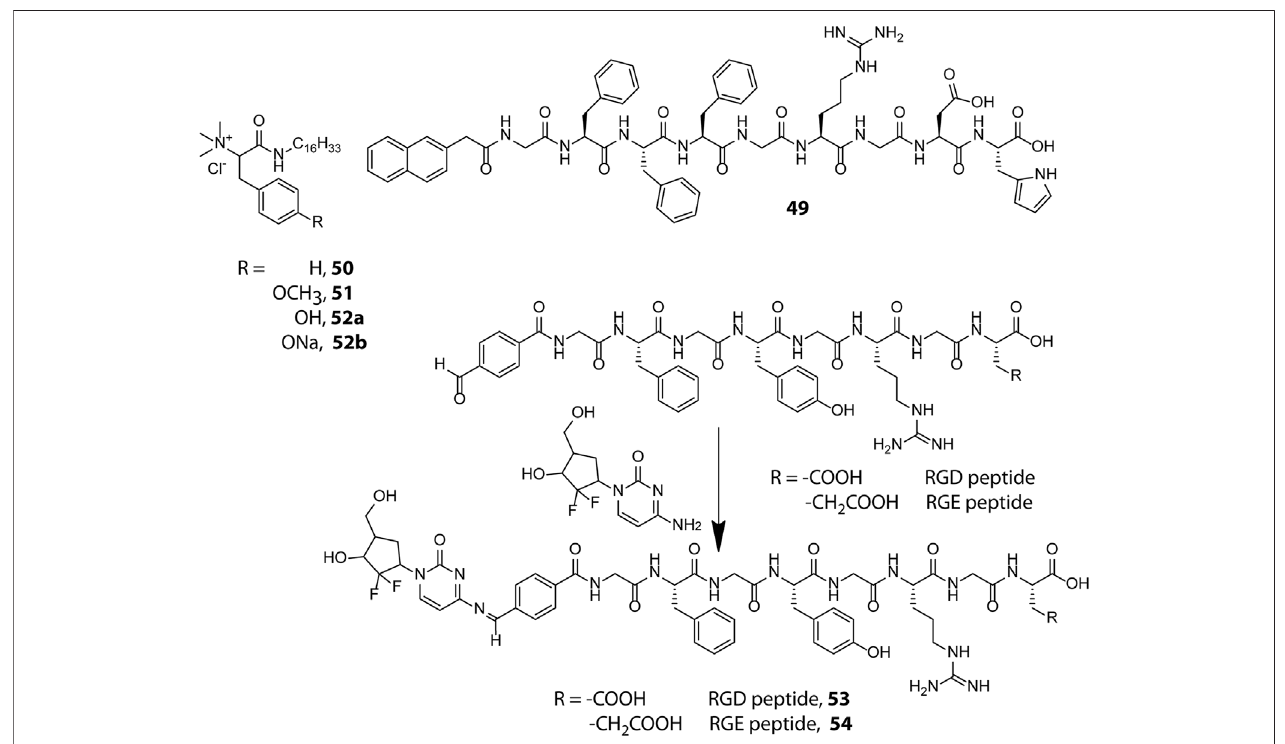
Scheme 1 | Chemical structures of exemplary pH responsive peptide hydrogelators used for therapeutic